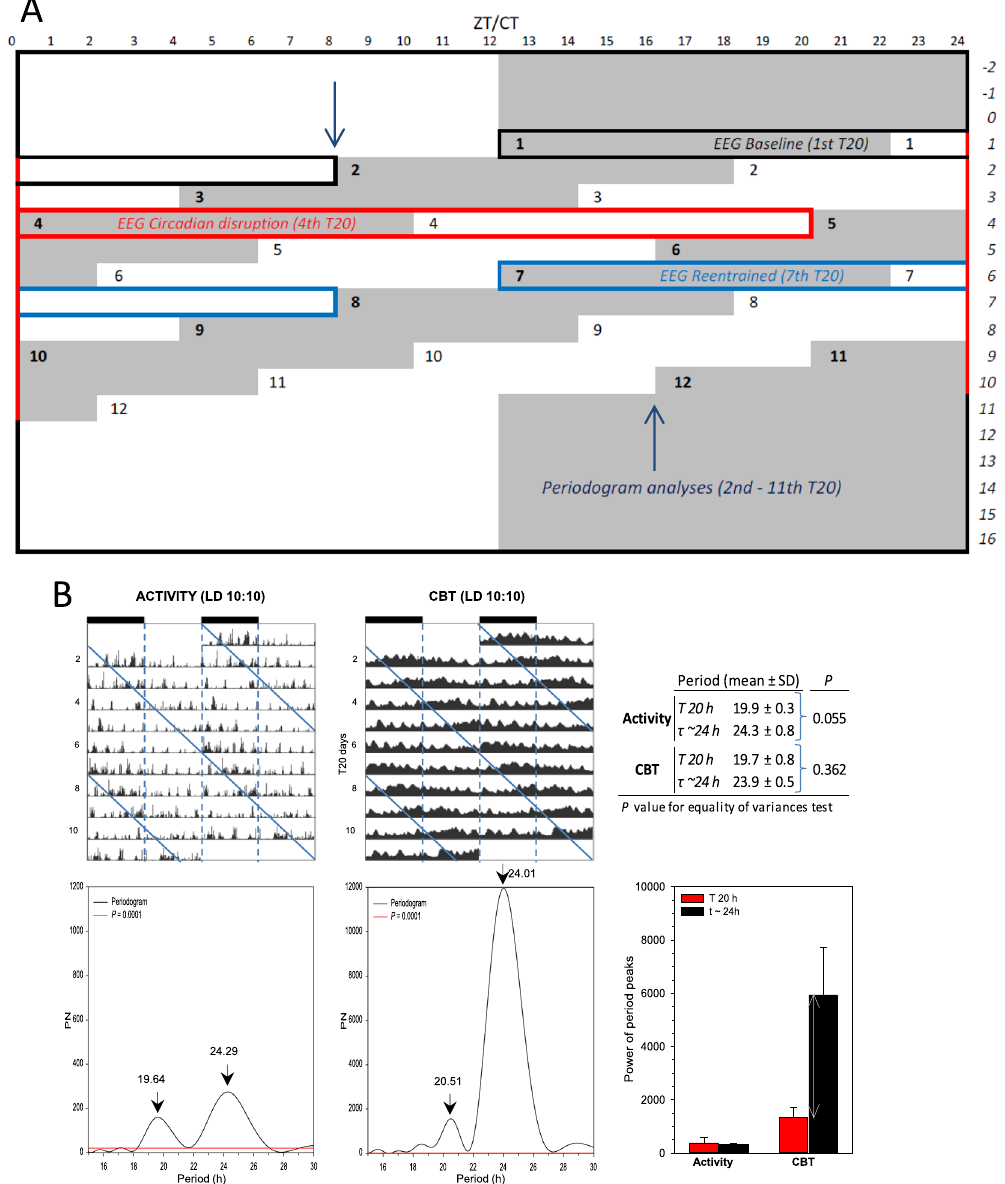
Figure 1. ( A ) Raster plot of the short day (20-h) forced desynchrony protocol in mice (n = 5). The first 10:10LD (T20) cycle (baseline/aligned) started at dark-onset (ZT12 of the previous 12:12LD). The dark-onset of the fourth T20 (misaligned) occurred ‘out of the phase’ (beginning of the subjective day based on preceding T24). The dark-onset of the seventh T20 (re-aligned) occurred ‘back in phase’ (beginning of the subjective night based on preceding T24). Periodogram (Lomb-Scargle; P < 0.0001) analyses were performed on the activity/ temperature data from 2 nd T20 cycle until 11 th T20 cycle (between dark blue arrows). EEG data were scored for vigilance states (VS) of the baseline (black rectangular open box), misaligned (red box) and re-aligned (blue box) cycles. ( B ) Actograms revealed both a 20 and a 24-h rhythm component for gross activity and core body temperature under T20 conditions. ( Upper ) Double plotted actograms for motor activity and temperature of a representative mouse under a 20-h LD cycle. The vertical dashed lines of the actograms denote the light and dark phases of the 20-h rhythm component. The diagonal lines of the actograms indicate the onset of the 24-h rhythm component. ( Lower ) Lomb-Scargle periodograms of the time series represented on the actograms. The analysis yielded statistically significant peaks ( P < 0.0001) for the τ ~24 -h and the T 20 -h rhythms (black arrows). The numbers on top indicate the period of the significant peaks in hours. ( Top-right ) Table representing the averaged periods (AVG ± SD, B6: n = 5) of the 20 and 24-h rhythms. Statistics are indicated by P values for the equality of variance test showing that the 20-h component of activity (19.9-h) had a smaller variance (SD = 0.3) compared to the 24-h component of activity. ( Bottom-right ) Averaged histograms (AVG ± SEM) of the power of period peaks revealed a trend for an increase in the τ ~24 -h core body temperature power compared to T 20 -h core body temperature (indicated by the double-headed arrow; P = 0.062, paired t-